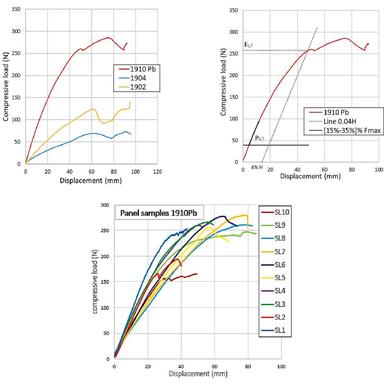
Representative example of the behavior curves of corrugated panels and measurements of their properties, as well as the behavior curves of ten 1910Pb panel samples under transverse compressive loading.